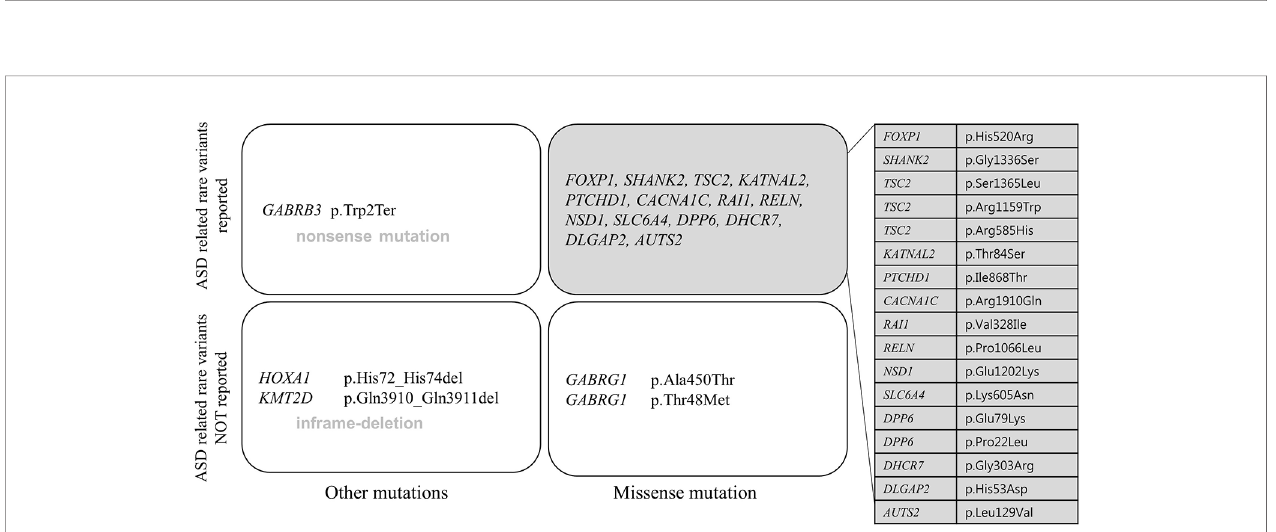
FIGURE 2 | Repeatedly reported variations of unknown signi fi cance. A missense mutation (p.His520Arg) of FOXP1 gene was most commonly found. Only FOXP1 gene variation appeared three times in 137 patients, the rest of missense mutations were found twice each. In perspective of mutation type, one nonsense mutation (p.Trp2Ter in GABRB3 gene), two in-frame deletions (p.Gln3910_Gln3911del in KMT2D gene, p.His72_His74del in HOXA1 gene), 21 missense mutations were related to each gene. Most genes have already been reported to be related to ASD according to OMIM and SFARI